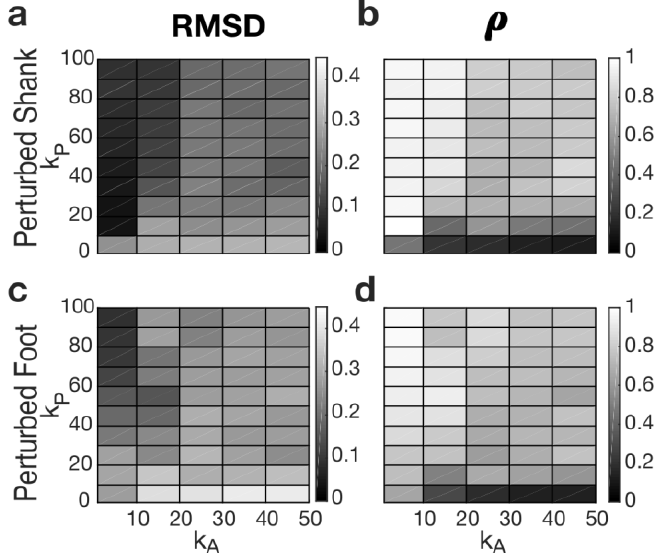
Figure 5. RMSD (( a ) and ( c )) and ρ (( b ) and ( d )) for each learning gain of the AOs (i.e., k A and k P ) and for both input signals (i.e., elevation angles of perturbed shank and foot). x -axes show k A ; y -axes show k P . Dark and light gray describe low and high values, respectively.